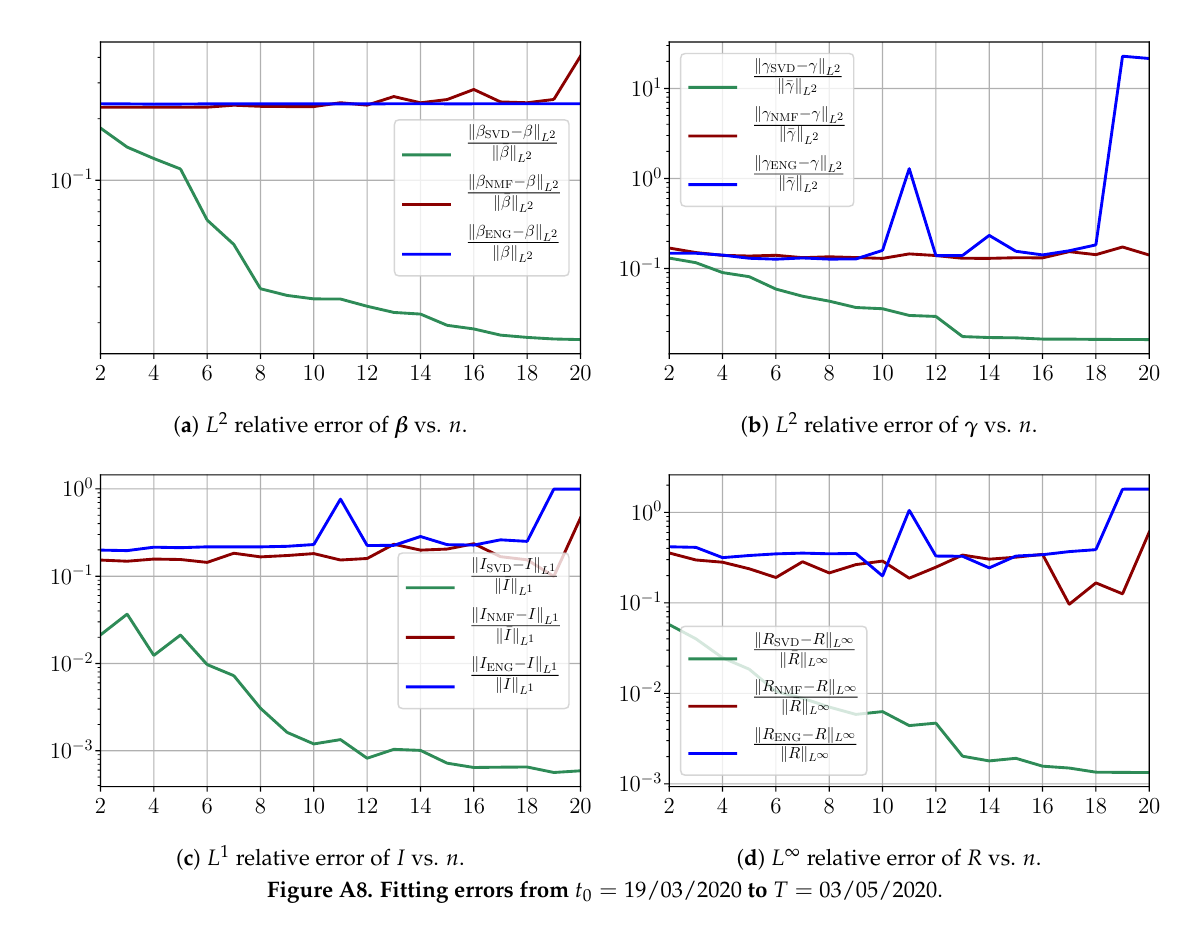
Figure A8. Fitting errors from t 0 = 19/03/2020 to T =